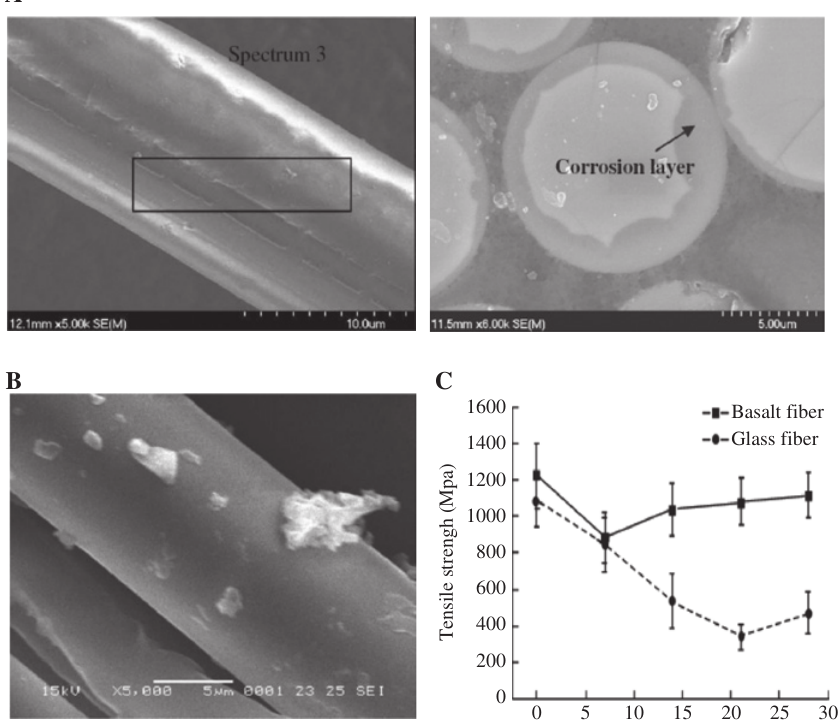
SO treated basalt fiber [19], 2 4